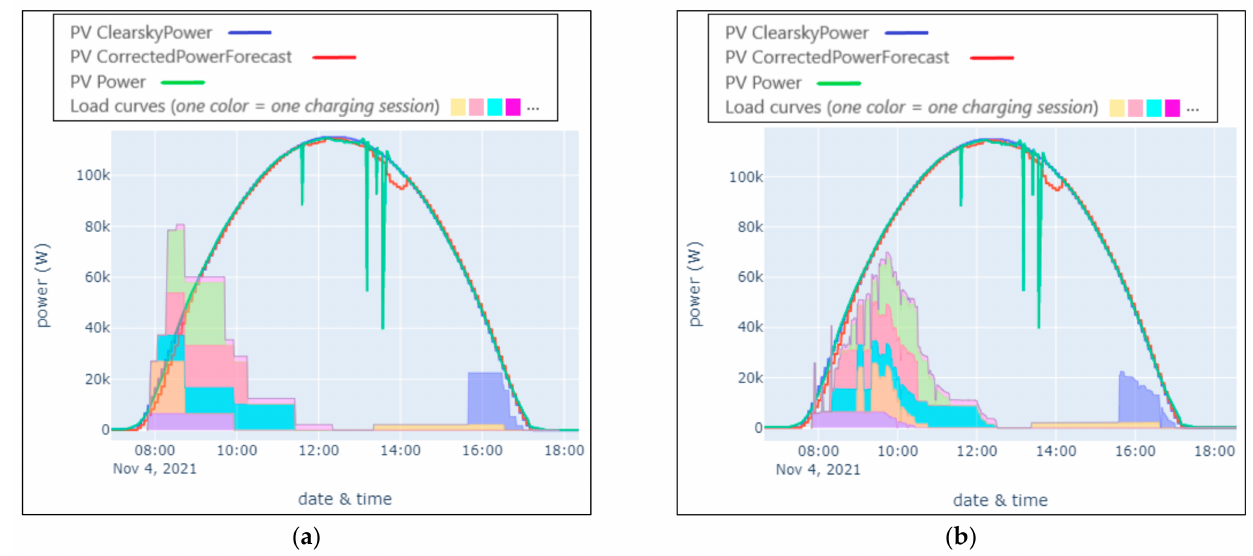
Figure 6. Results of 4th November 2021: ( a ) Stacked energies without control. The self-production rate SP u is 83%; ( b ) stacked energies with control. The self-production rate SP is 97%.